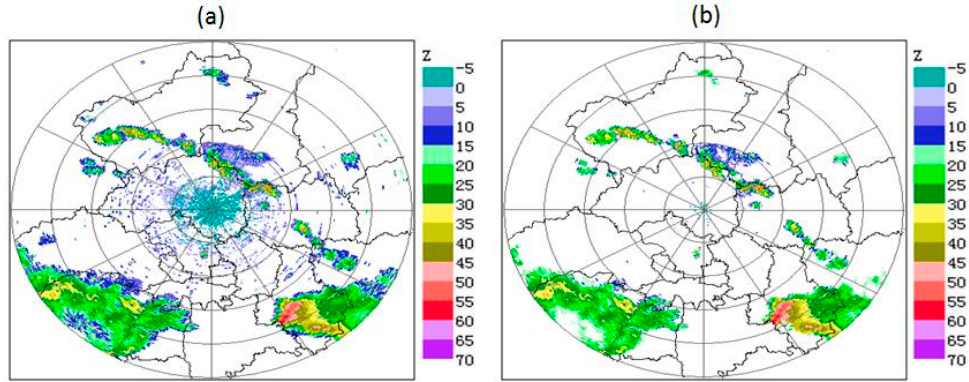
Figure 7. PPI displays of raw reflectivity Z H ( a ) and CAT-removed Z H ( b ) using the Bayesian method from Changping radar at 1.5 ° elevation angle at 08:00 (UTC) 2 July 2019.